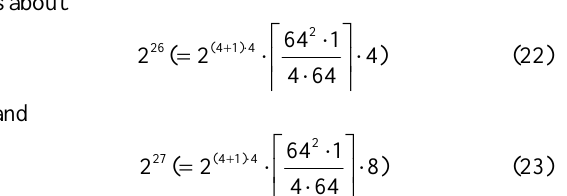
Table 2. One subkey recovery on reliability